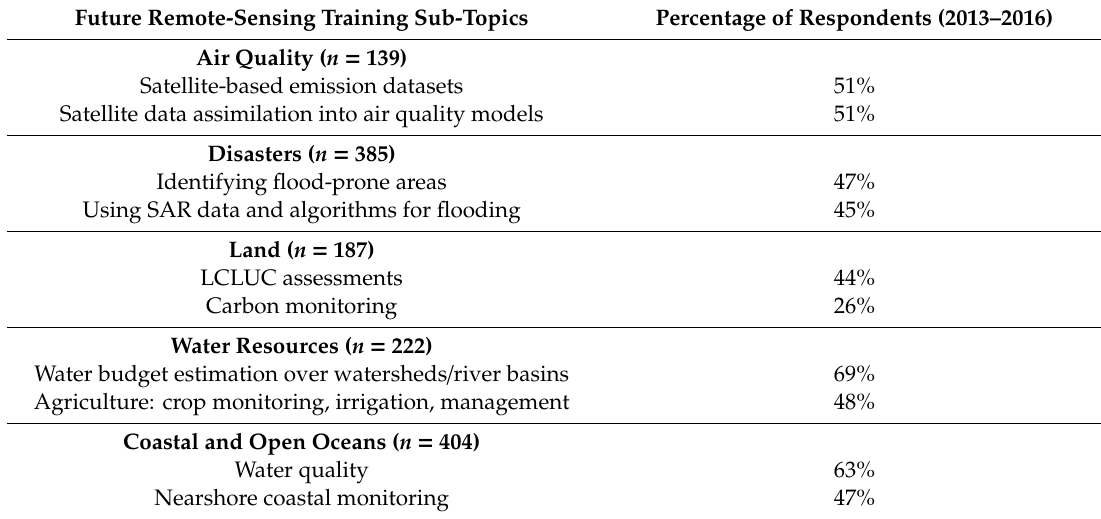
Table 1. Preferred remote-sensing training sub-topics. SAR—synthetic aperture radar; LCLUC— land-cover and land-use